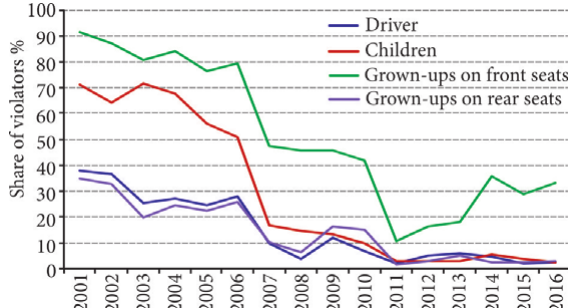
Fig. 3. Seat belt use rate in Estonia (2001–2016)